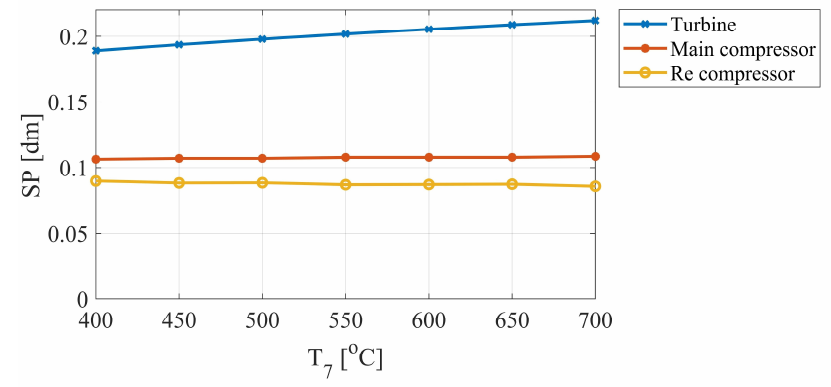
Figure 14. Size parameter ( SP ) vs. turbine inlet temperature ( T 7 ).